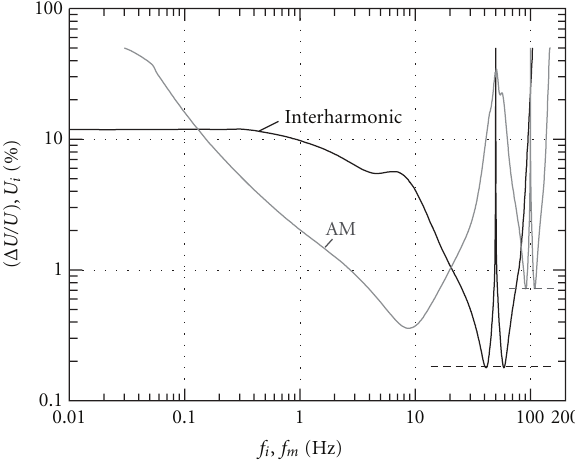
Figure 9: Characteristics: U i = f ( f i , P st = 1 = const) for u IN ( t ) defined with (3) and ( Δ U/U ) = f ( f m , P st = 1 = const) for u IN ( t ) defined with (2) and for AM modulation with sinusoidal